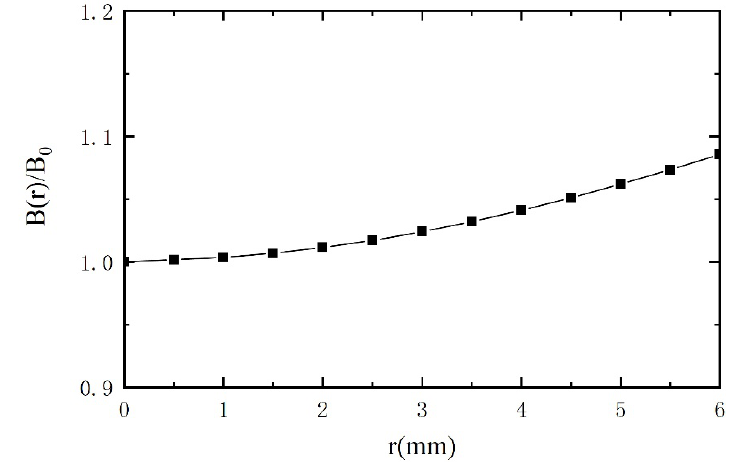
Figure 11. Radial distribution of relative magnetic flux density at z = 0.